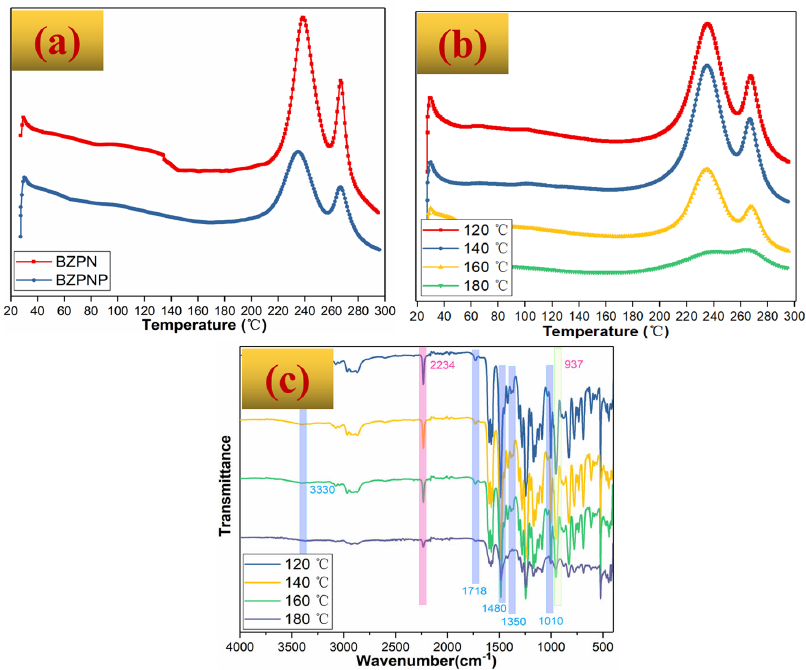
Figure 3. ( a ) DSC curves of BZPN and BZPN/AC/TW foam precursor, ( b ) DSC curves, and ( c ) FTIR curves of BZPN foam at various foaming temperatures.